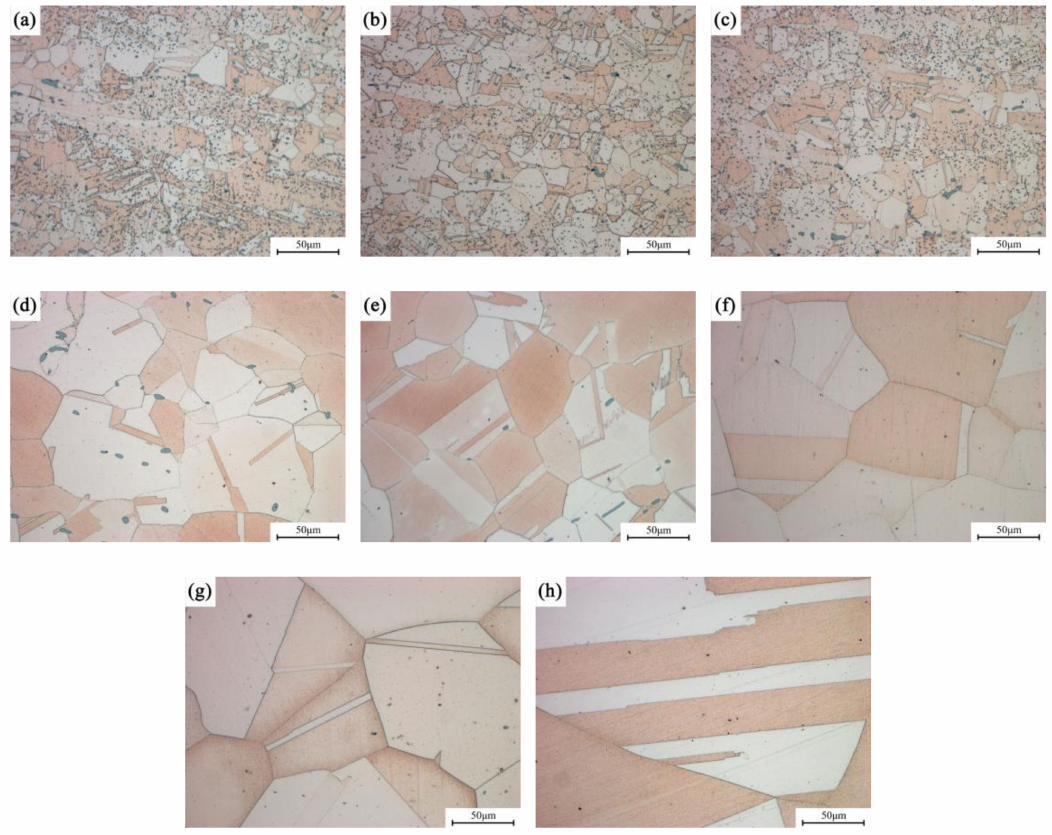
Figure 4. Optical microstructure of alloys aged at 1020 ◦ C for 1 h with di ff erent Ni / Co mass ratios; ( a – h )